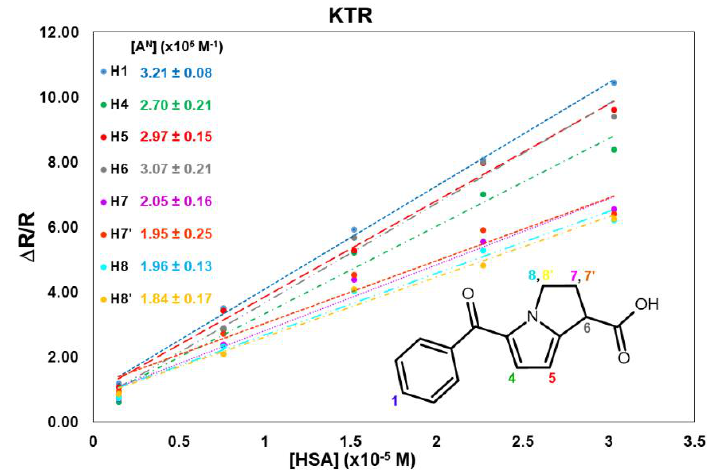
Figure 1. Normalized mono-selective relaxation rates plotted vs. HSA concentration and calculated affinity indexes for KTR protons.